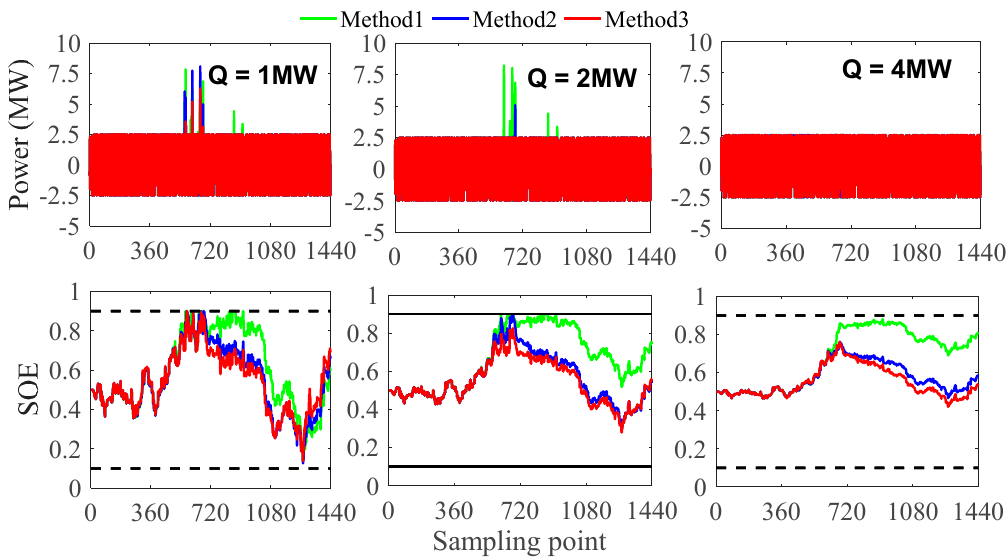
Figure 8. Comparison curve of Δ P G and SOE with three methods under different Q.